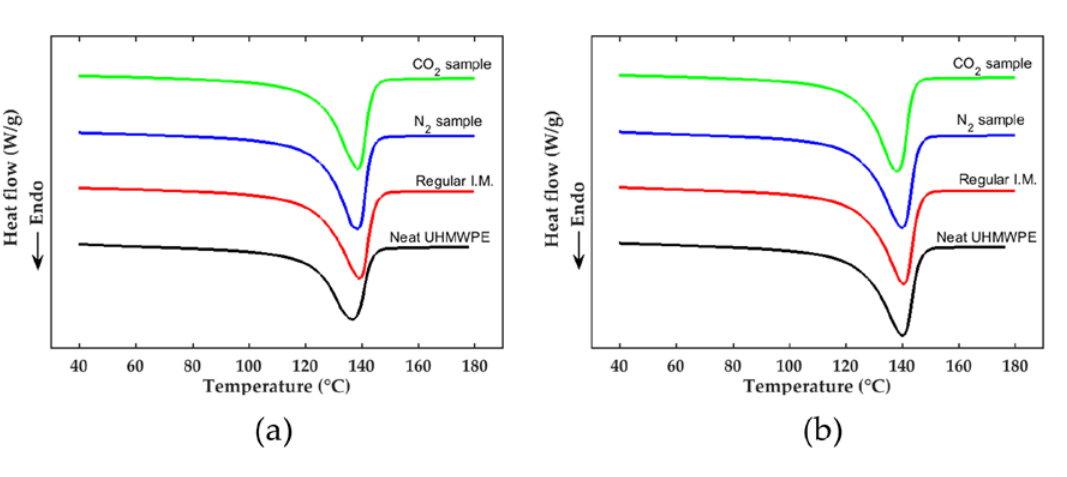
Figure 2. ( a ) The first heating and ( b ) the second heating of the differential scanning calorimetry (DSC) graphs of the injection-molded samples and neat ultra-high molecular weight polyethylene (UHMWPE). The average thermal behavior of injection-molded samples obtained from the first heating thermograms.